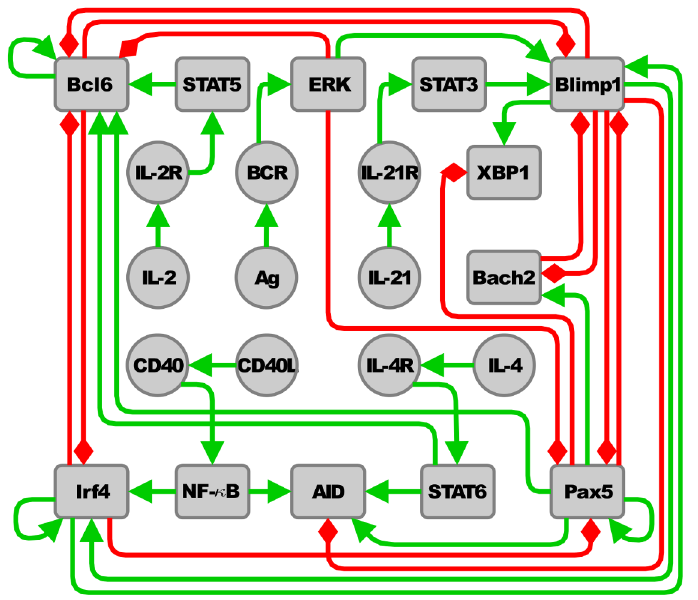
Fig 2. The regulatory network of B cells. Nodes represent molecules or molecular complexes. Positive and negative regulatory interactions among molecules are represented as green continuous arrows and red blunt arrows